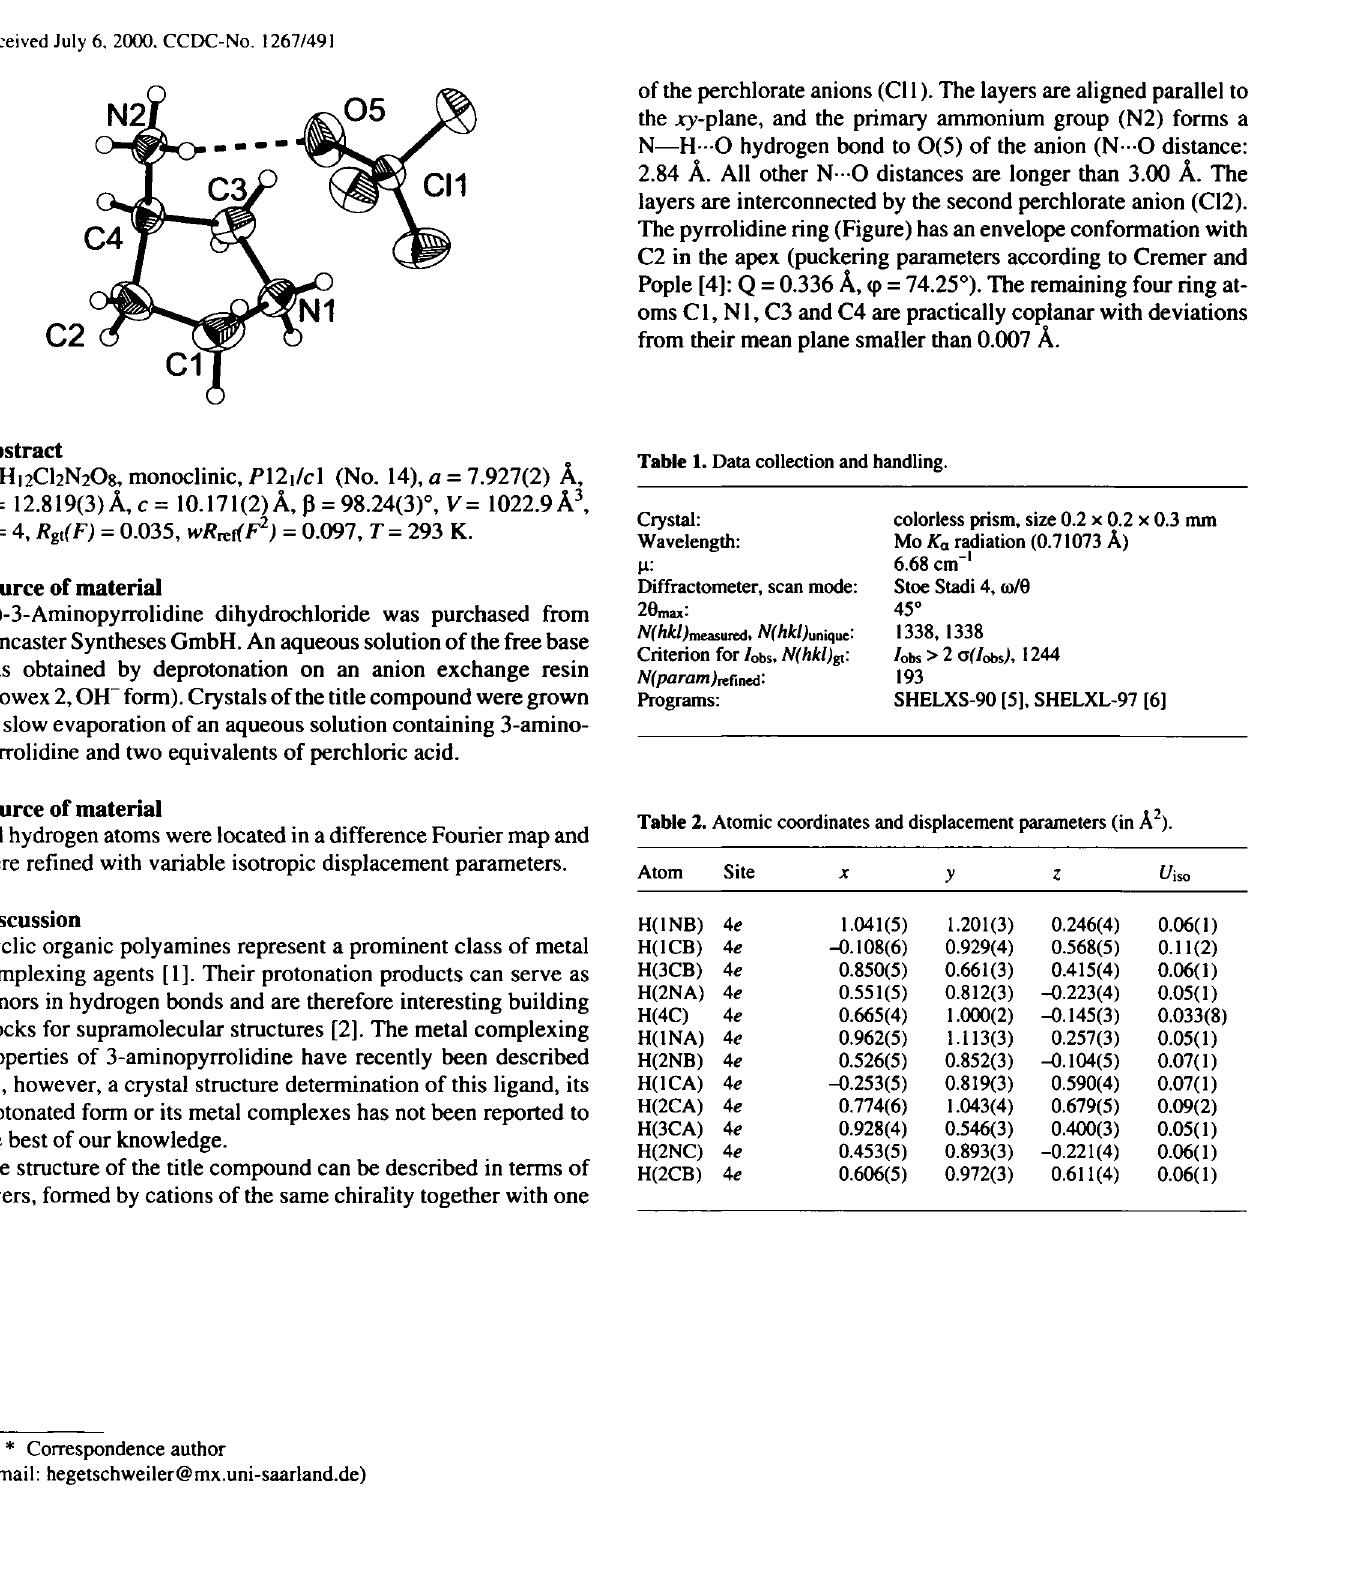
Table 1. Data collection and handling.